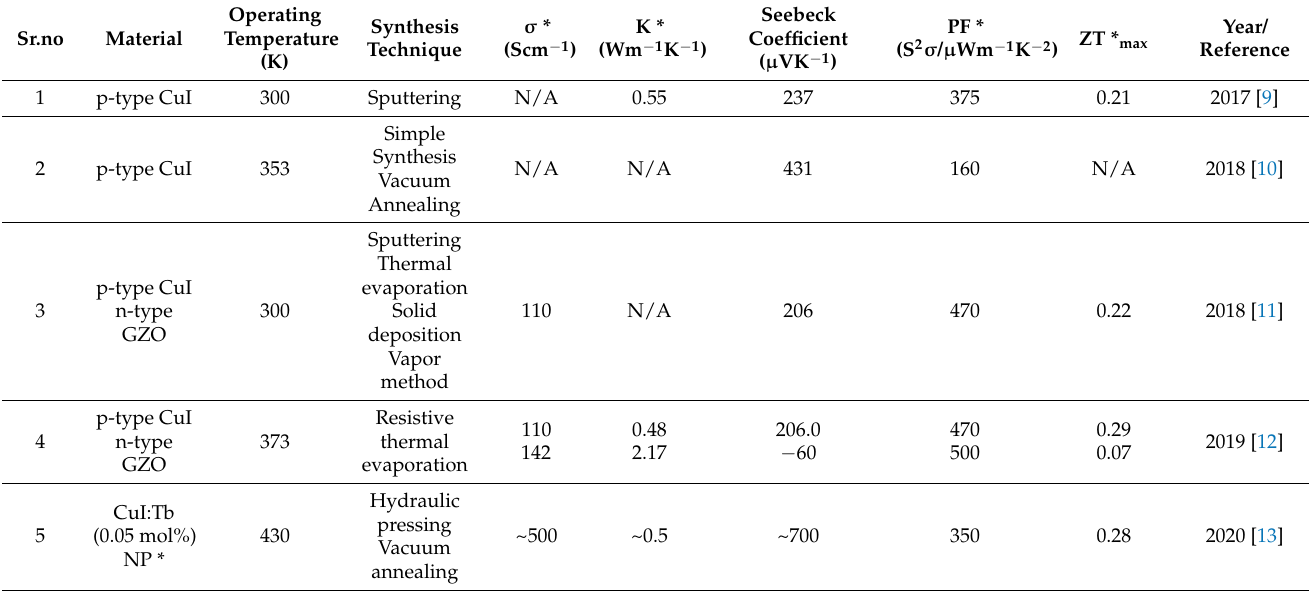
Table 1. Prominent nanostructured copper-iodide (CuI) alloys/composites thermoelectric materials. Sr.no